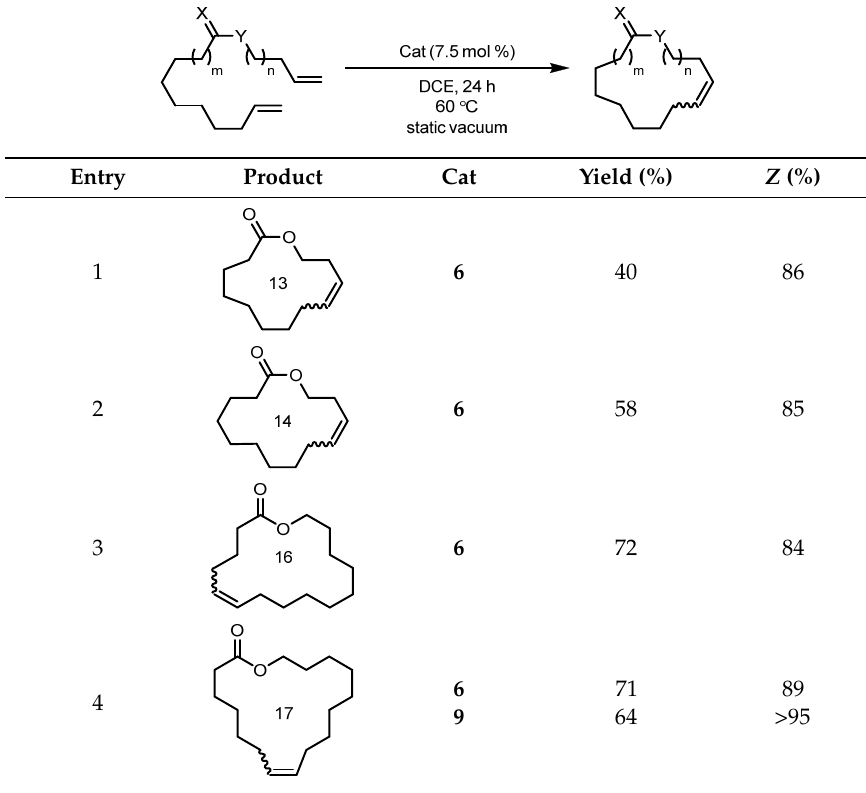
Table 4. Z -Selective macrocyclic ring-closing metathesis (mRCM) employing 6 and 9 .